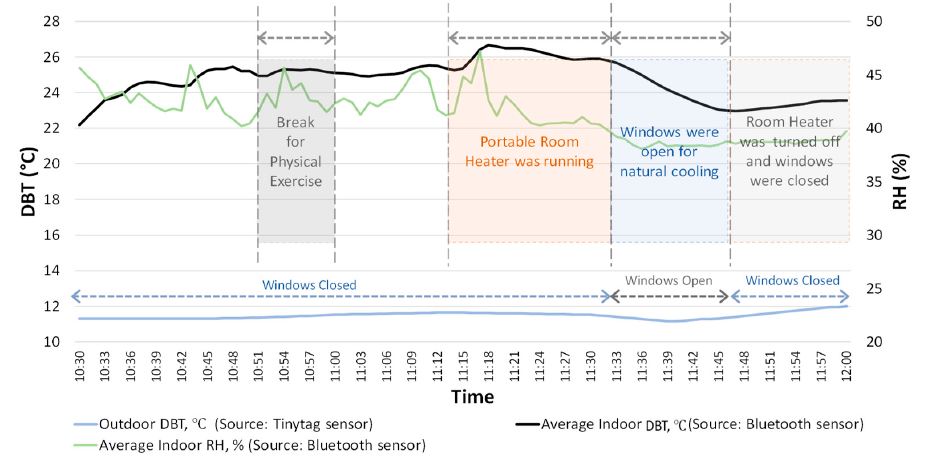
Figure 15. Recorded Average indoor DBT and RH and change of thermal comfort parameters during a workshop (source: Portable Bluetooth sensors).